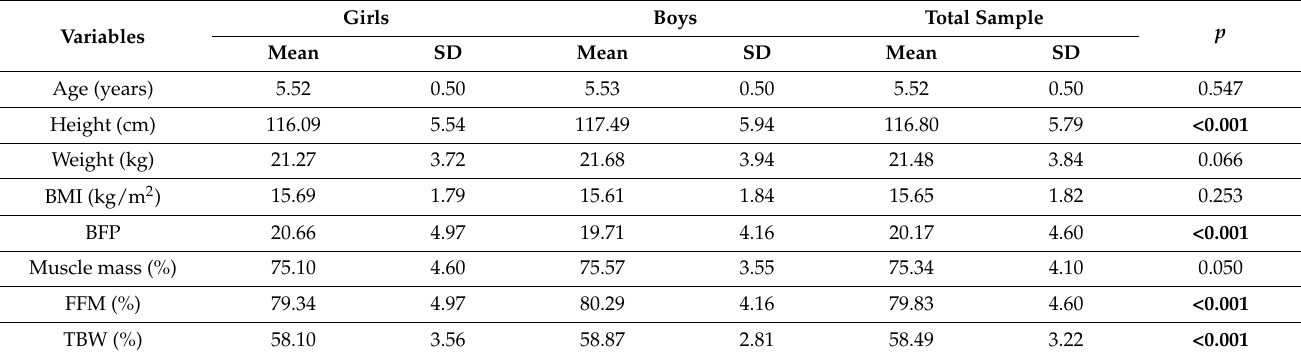
Table 1. General characteristics of the study population.